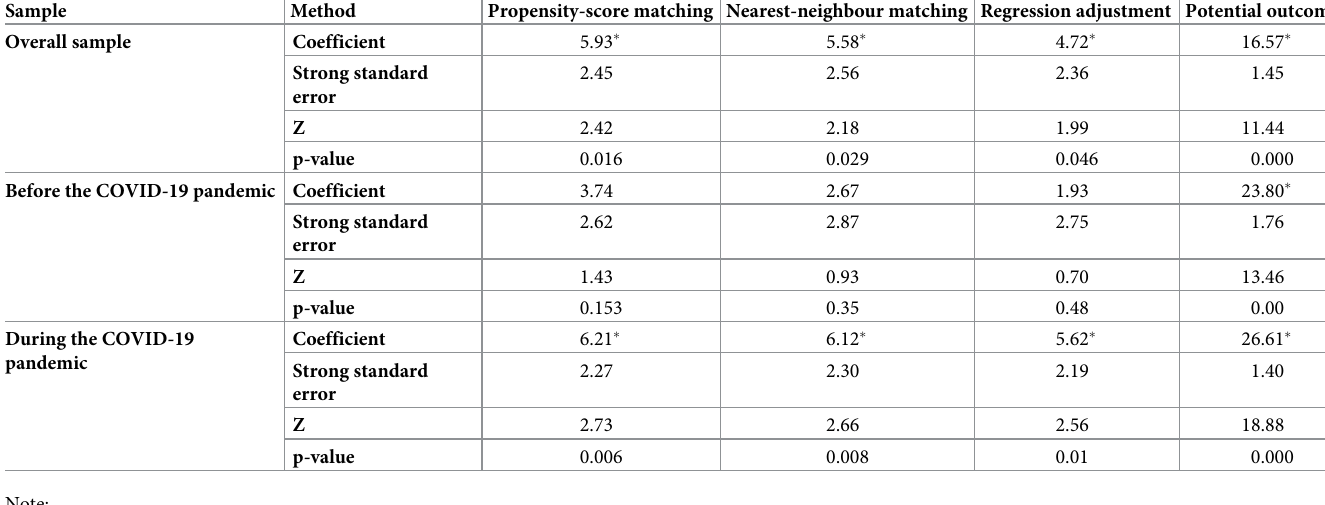
Table 2. The estimated results of treatment (coping strategies) effects in order to assess the impact of status on labour market regarding stress scores (control vari- ables: Gender, marital status, age